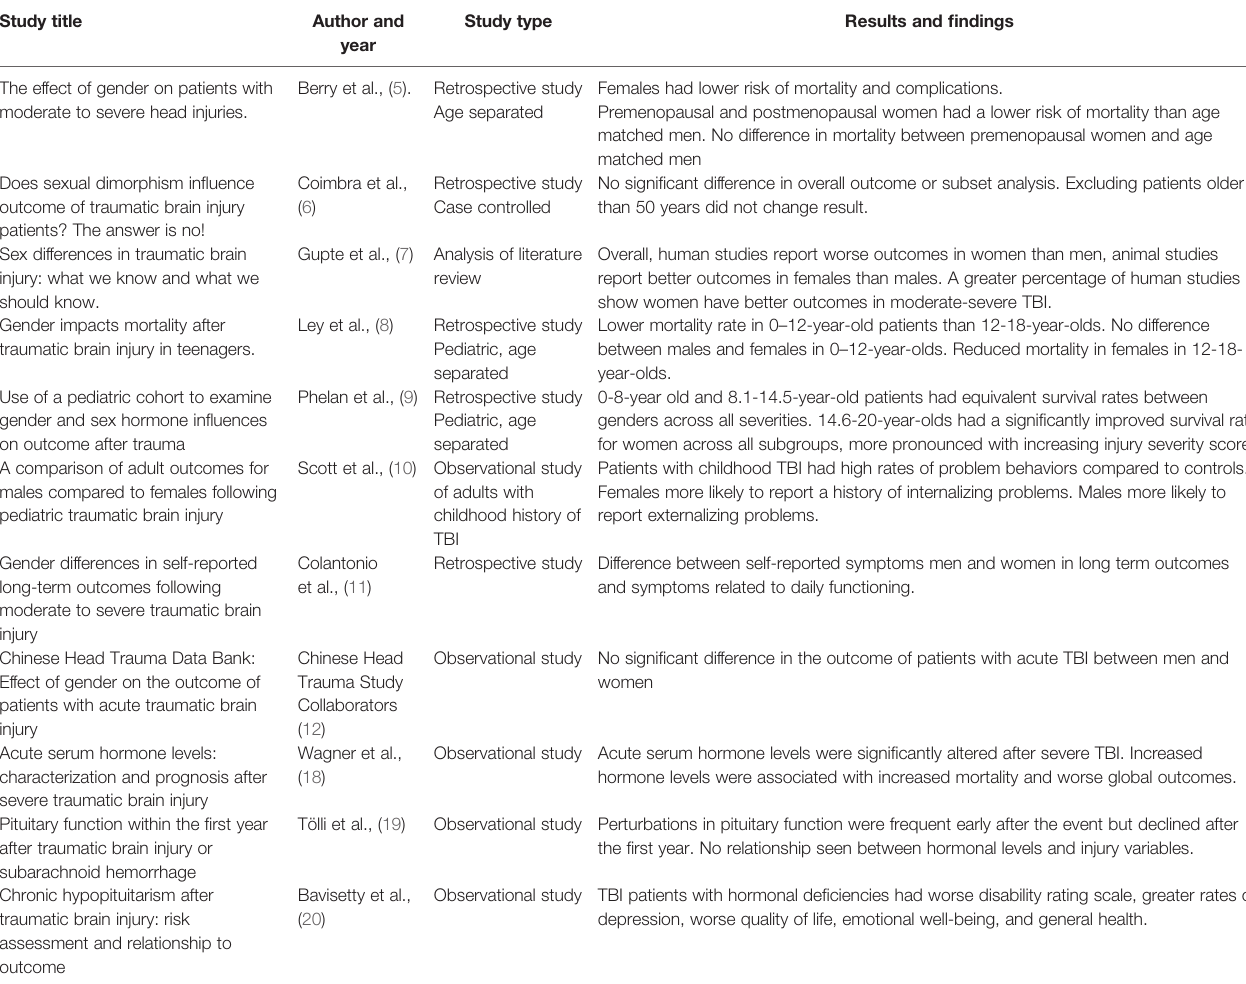
TABLE 1 | Human studies of sex-based differences in traumatic brain